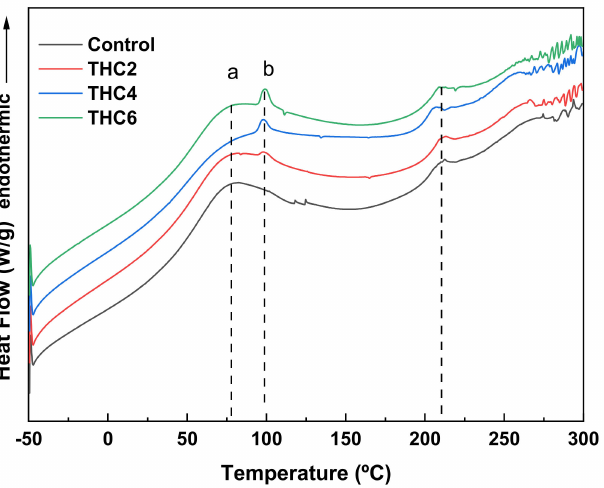
Figure 5. DSC thermograms of collagen scaffolds: ( a ) free and bound water release, ( b ) THC melting, and ( c ) collagen thermal